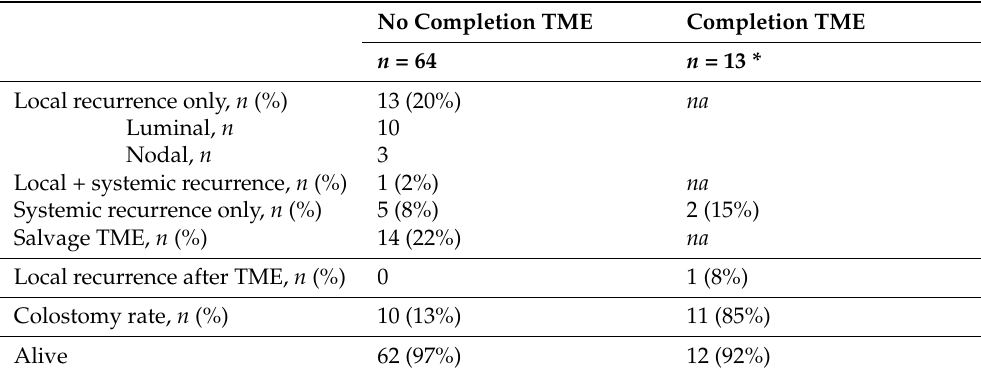
Table 3. Oncological outcomes and organ preservation subdivided for patients with and without completion TME after local excision.